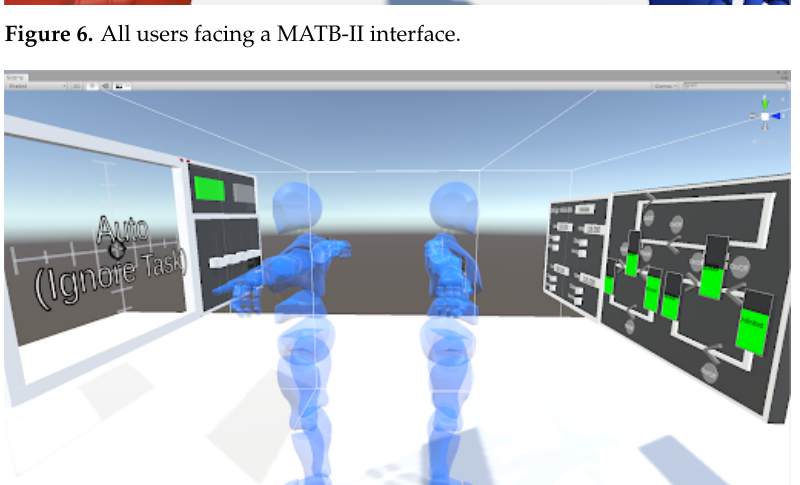
Figure 7. MATB-II system cut into two halves facing each other. The confederate’s avatar is on the left in front of the first half of the interface with the TRACK and SYSMON tasks, and the participant’s avatar is on the right in front of the other half of the interface with the COMM and RESMAN